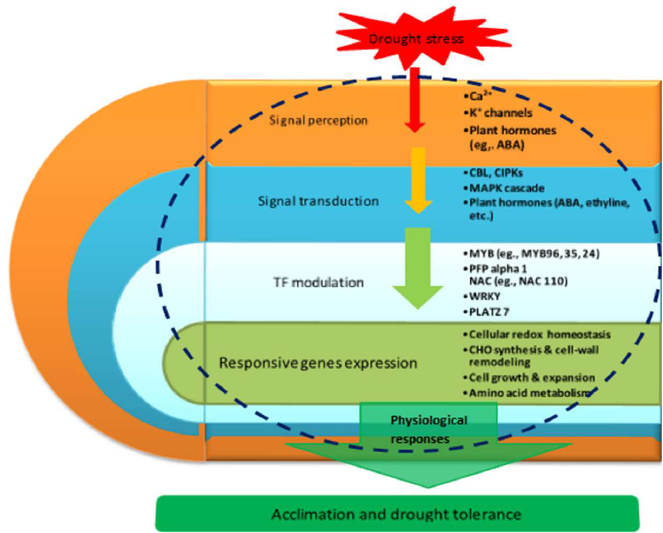
Figure 7. Schematic molecular model of maize seedling drought stress tolerance. This model was developed based on our key putative components of drought response identified in this study, supported by previously described schemes of plant abiotic stress response pathways/networks [9,38,72]. The blue dotted enclosure signifies the molecular interactions occurring in the cellular environment.